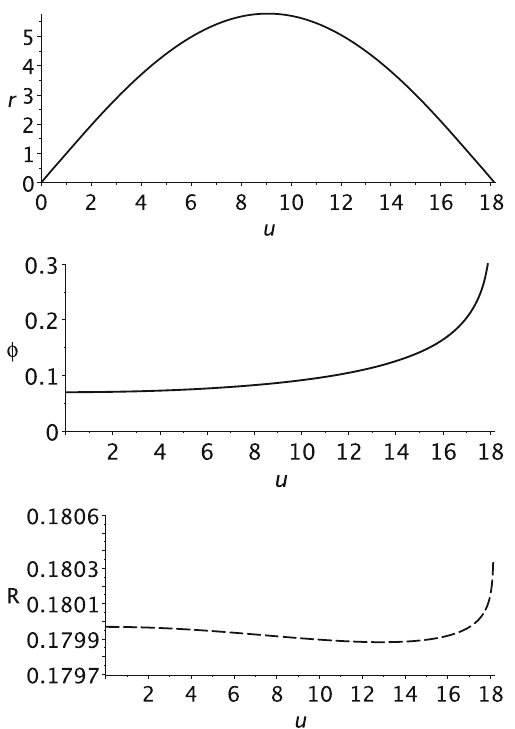
Fig. 6 Solution without a conical singularity, r (cid:8) ( u max ) = − 1. The extra space metric function r ( u ) , the Ricci scalar R ( u ) of 6D space and the scalar field φ( u ) for f ( R ) = aR 2 + bR + c and V (φ) = ( m 2 / 2 )φ 2 (units m = 1). The parameter values are m = 0 . 1 , b = D 1 , a = − 10 . 9 , c = − 0 . 0021. Additional conditions are: φ 0 = 0 . 07 , H = 0 . 1 The value of R ( 0 ) follows from Eq.(23). Here R ( 0 ) (cid:10) 0 . 179969 , r (cid:8) ( u max ) = −